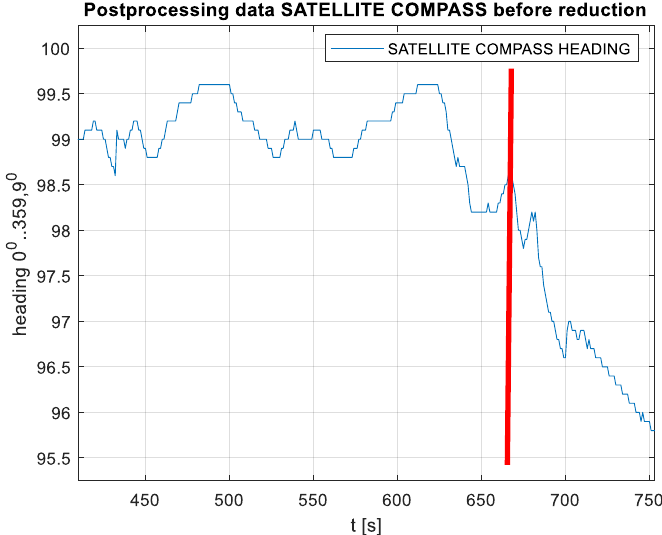
Figure 16. Raw heading value results during the stationary test with the Advance Navigation compass used as an example. The orange line denotes the satellite signals in the moment of being completely obscured.